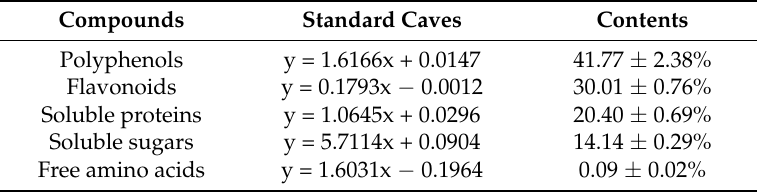
Table 1. The chemical class of extracts from olive leaves (EOL).